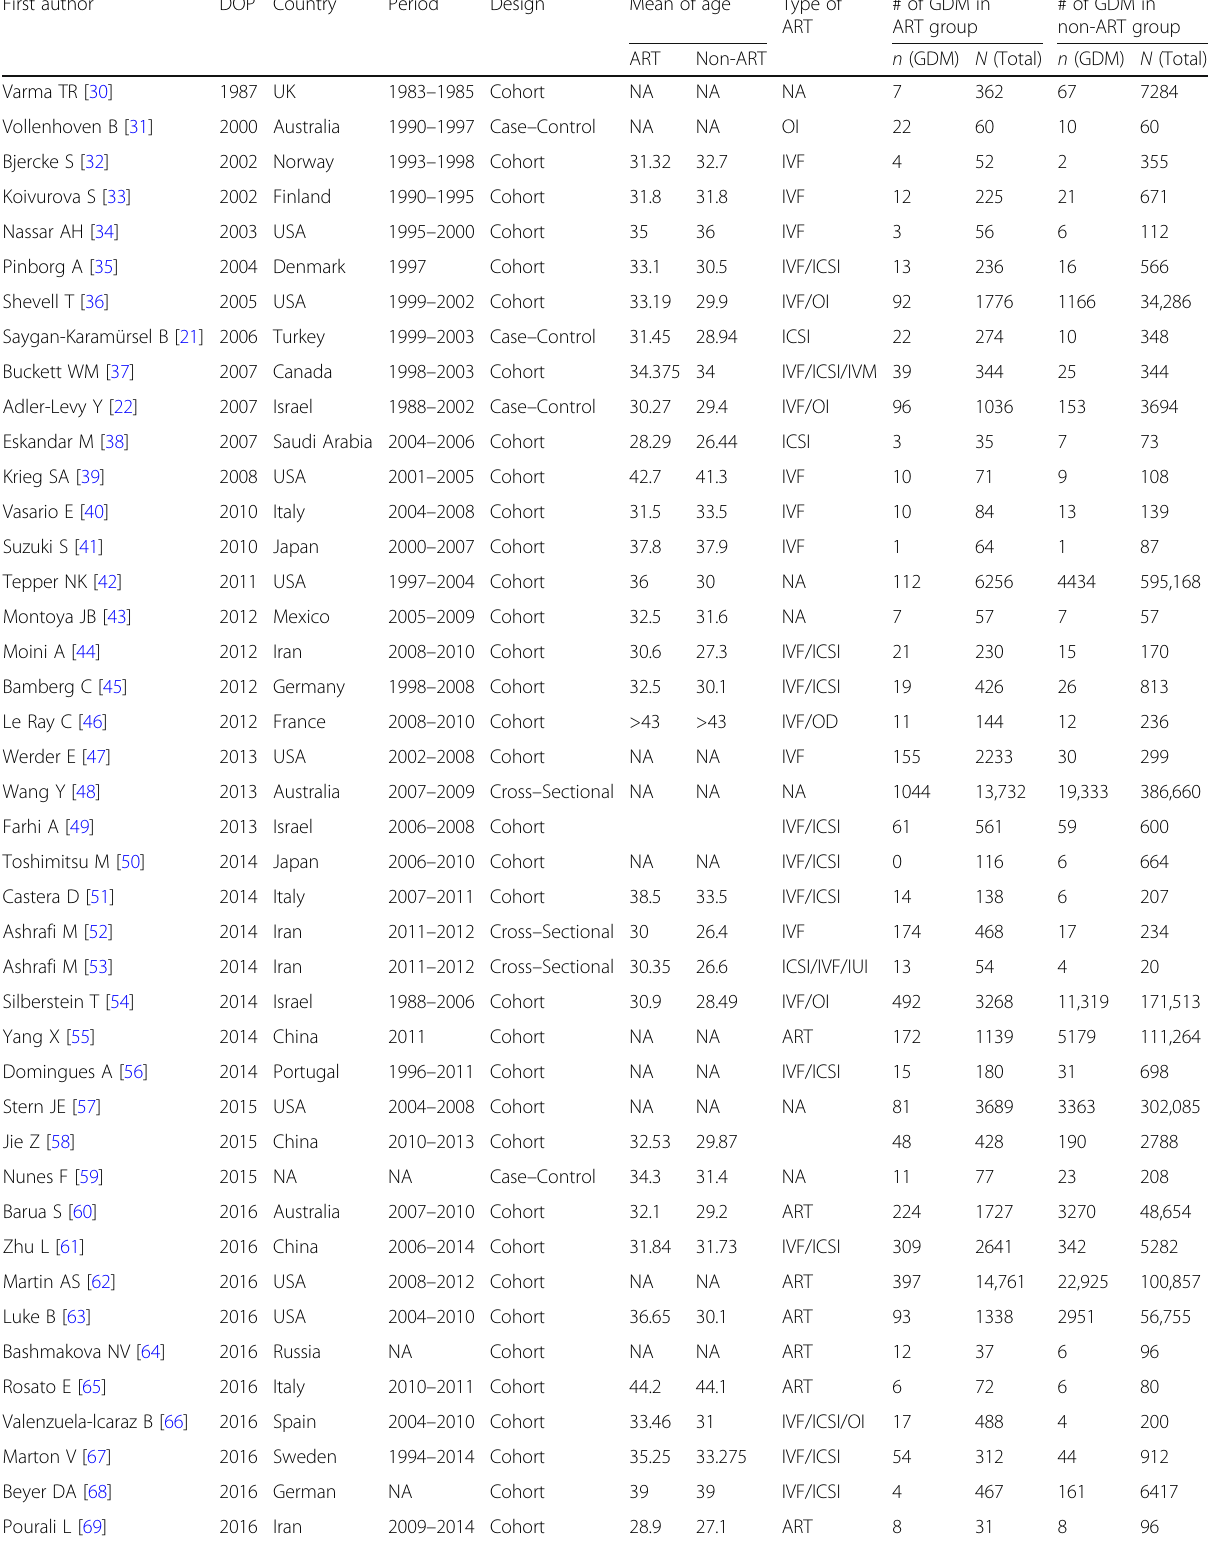
Table 2 Characteristics of the primary studies included in the